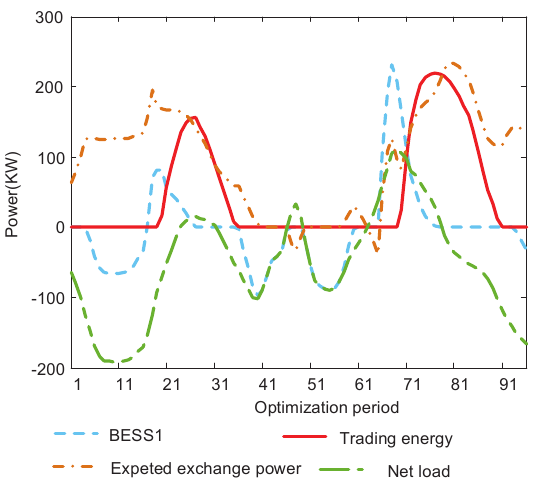
Figure 10. The optimal variables and net load in MG1 on Day 1 of Scenario